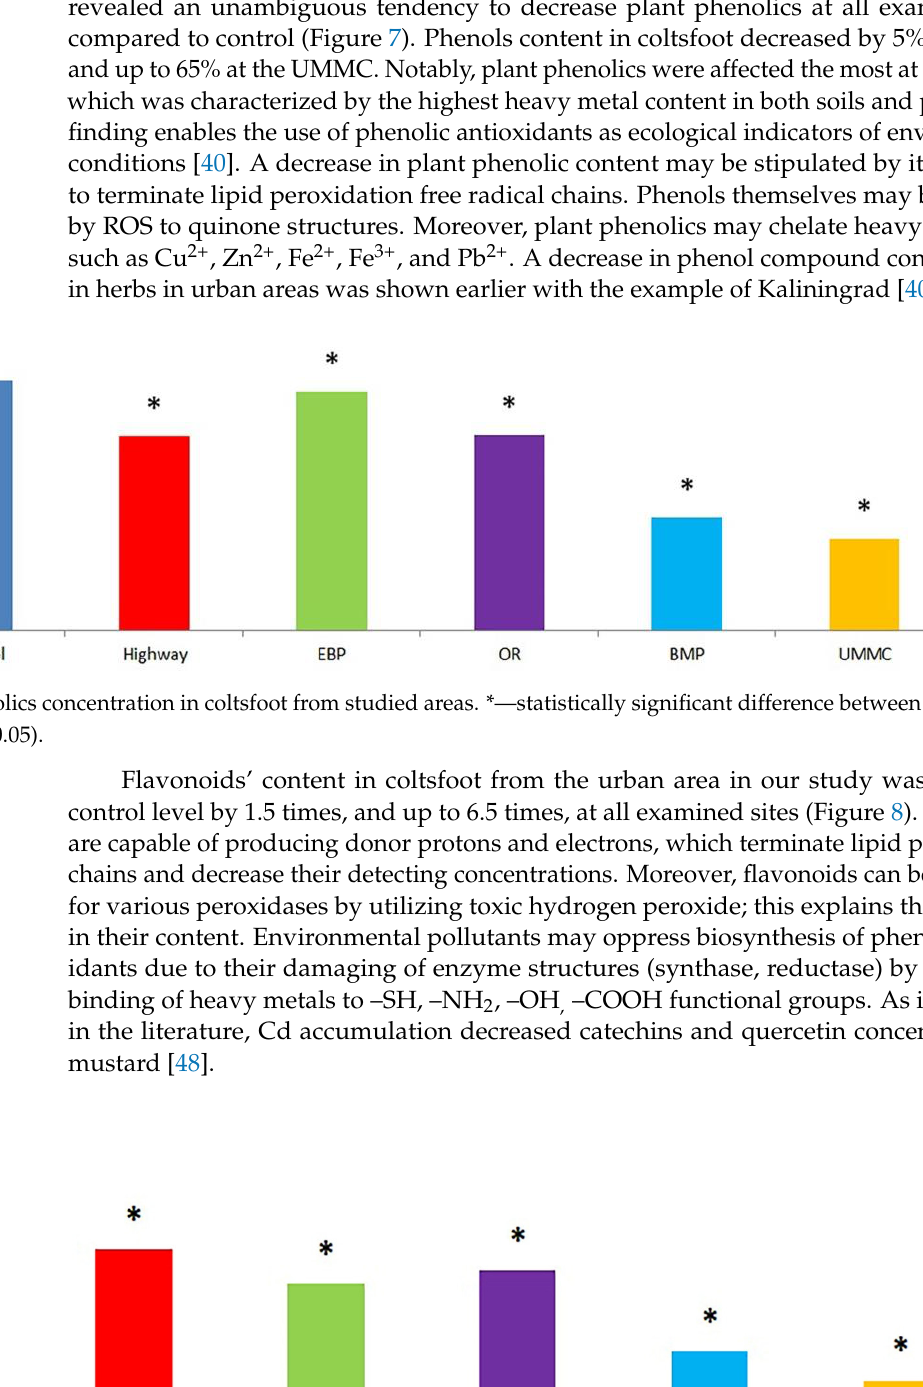
Figure 8 . Flavonoids ’ concentrations in coltsfoot from studied areas. * — statistically significant difference between control and test group ( p ≤ 0.05).